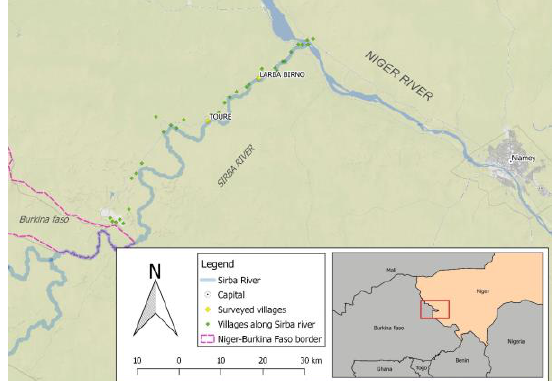
Figure 7: Detail of the surveyed areas. On the left Larba Birno, and on the right Tourey.